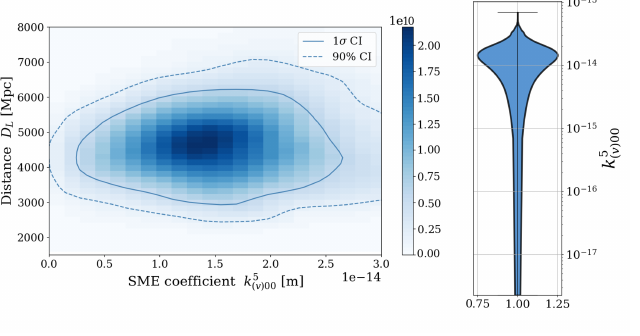
( 5 ) coefficient for a simulated coalescence of a ( V ) 00 ( d ) plane, and the ( V ) 00 ( 5 ) marginalizing the source and systematical ( V ) 00